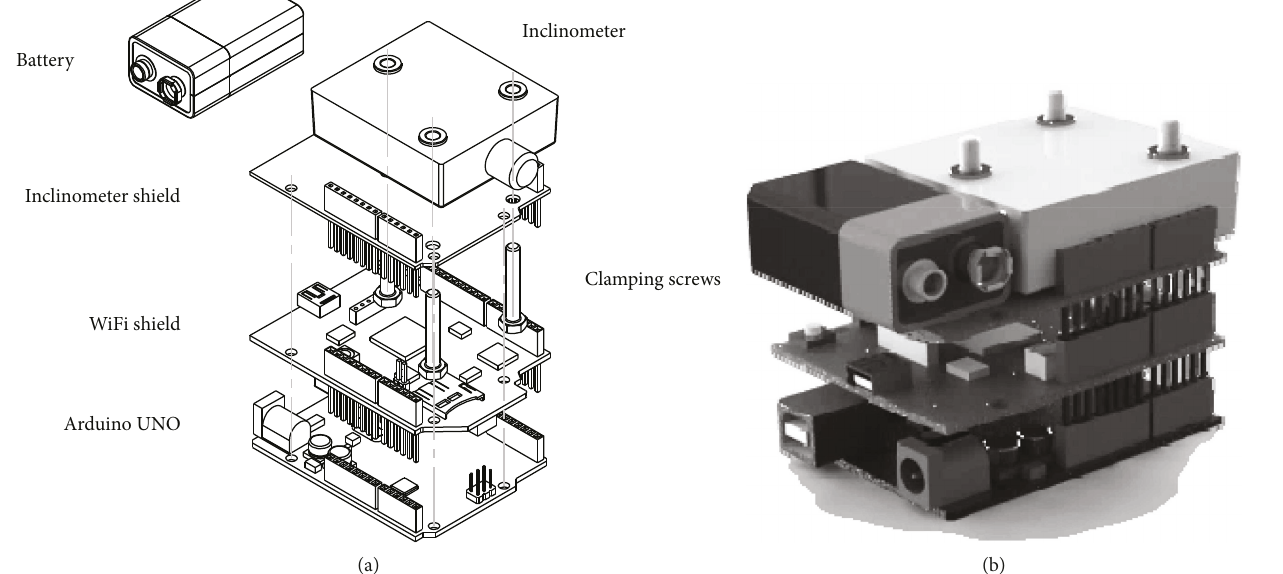
Figure 3: Measurement equipment: exploded view (a) and CAD rendering (b).